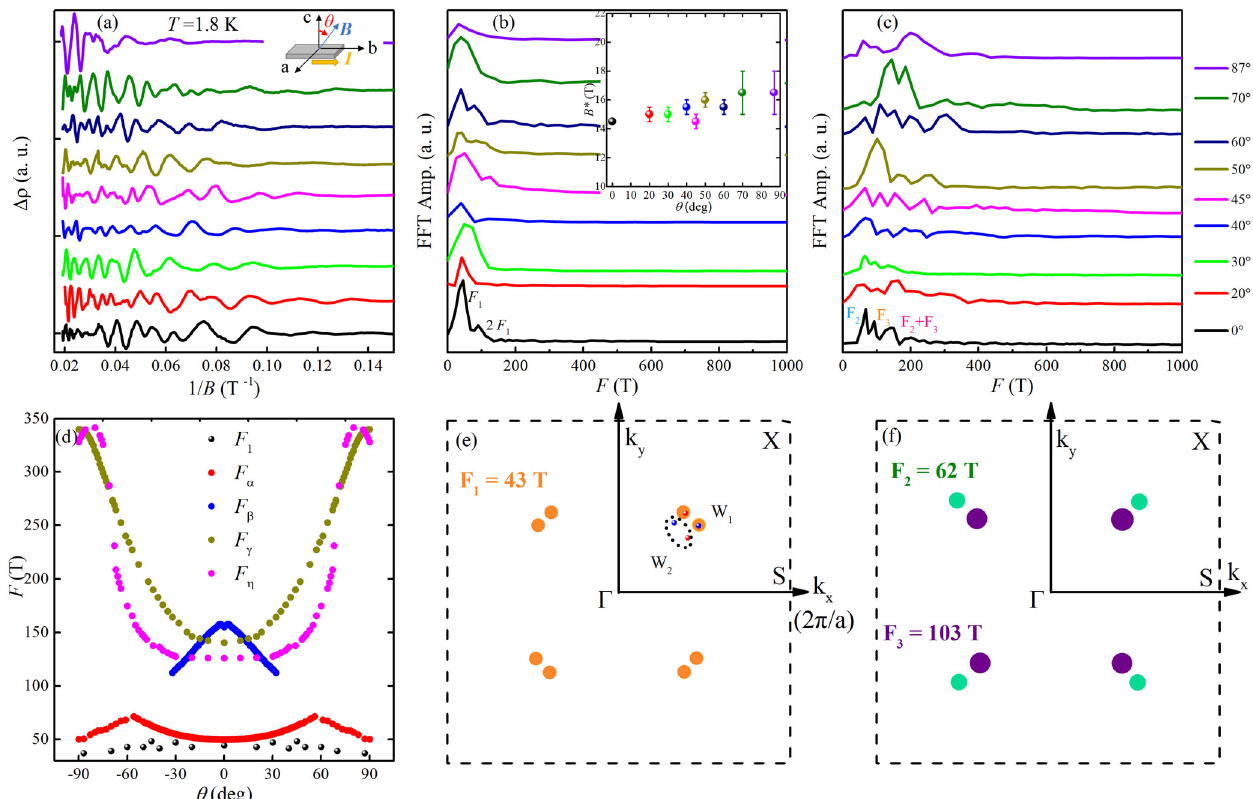
Fig. 5 Angular dependence of experimental and calculated quantum oscillation frequencies and the Weyl points. a Background- subtracted SdH oscillatory part as a function of 1/ B at T = 1.8 K under various angles. The inset on the top is the schematic diagram of the measurements. b , c The FFT spectra for different angles and magnetic fi eld ranges and the data are shifted along the vertical axis for clarity. The inset in graph b displays the critical fi elds of every angle and the error bars are de fi ned as standard deviation. d The angular dependence of the corresponding measured oscillation frequency of F 1 pocket (black solid symbol) as well as the calculated frequencies F α , F β , F γ and F η . e and f Schematic illustration of the Lifshitz transition in the BZ by the sketch of Fermi pockets which correspond to ( b ) and ( c ), respectively. Two tiny hole pockets (in orange) with F 1 = 43 T located along the sides of Γ − X transform into one electron pocket in green with F 2 = 62 T and one hole pocket in violet with F 3 = 103 T after LT, implying the existence of a van-Hove singularity. The pockets along Γ − S are not shown here (see Supplementary Fig. 9). In graph e , the projection of two pairs of Weyl points around the Γ − X line in the BZ is illustrated, in which W 1 and W 2 are indicated. Weyl points with opposite chiralities are marked as red and blue